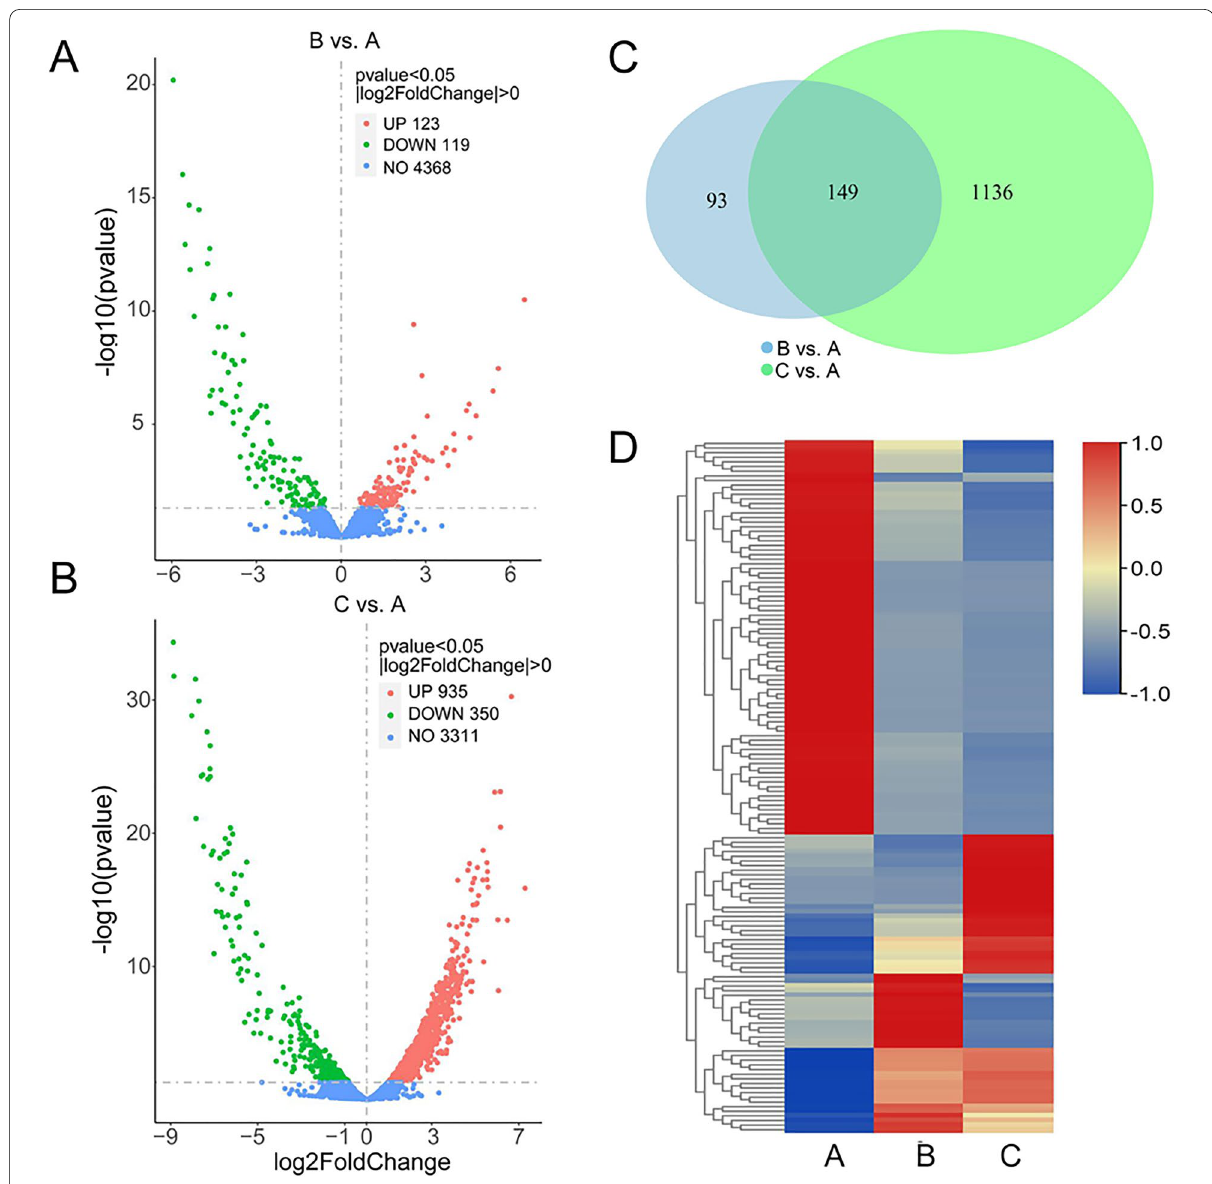
Fig. 3 Analysis of differentially expressed genes (DEGs) under three conditions. A Volcano plot of DEGs in the B vs. A group. B Volcano plot of DEGs in the C vs. A group. Red dots represent upregulated DEGs, green dots represent downregulated DEGs, and blue dots represent unchanged genes. The DEGs were identified with a p value < 0.05 and |log2FoldChang|> 0. C Venn diagram between the B vs. A group and the C vs. A group. D Heatmap of shared genes involved in both groups. The heatmap was drawn using TBtools software, and the rows were normalized and